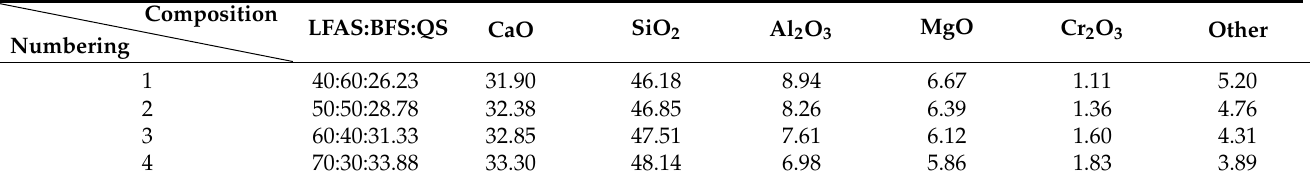
Figure 1. CaO–Al 2 O 3 –SiO 2 ternary phase diagram with 5% MgO. Table 2. Mass proportion and main composition of base glass raw materials (mass fraction, %).